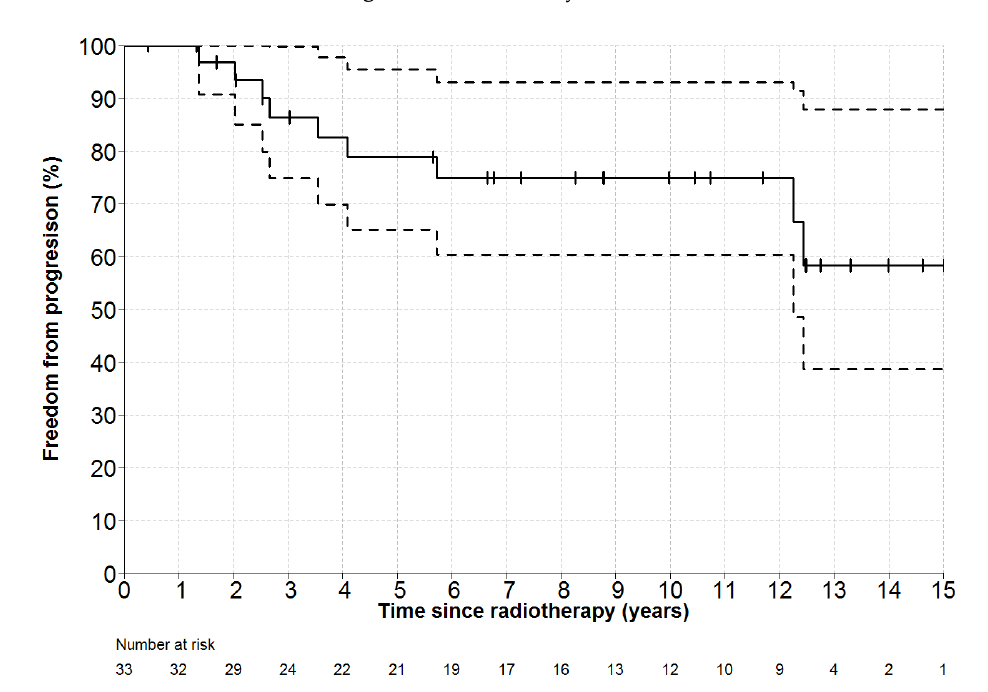
Figure 3. Freedom-From Progression (and 95% CI for point estimates) for all patients. Number at risk represents number of patients still under observation, without an event, at the start of the relevant time interval.